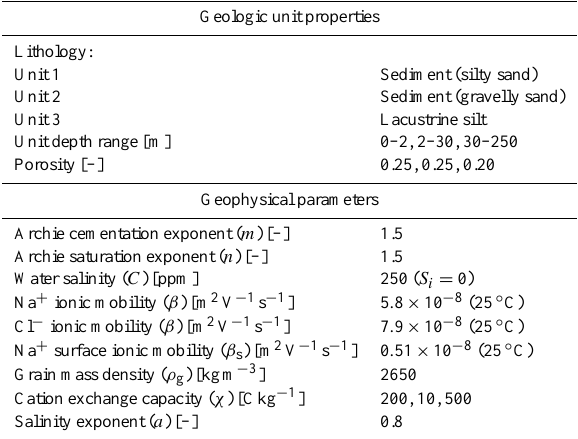
Table 1. Description of geologic units and physical properties used in numerical simulations. Entries separated by commas represent parameters with different values for each of the lithologic